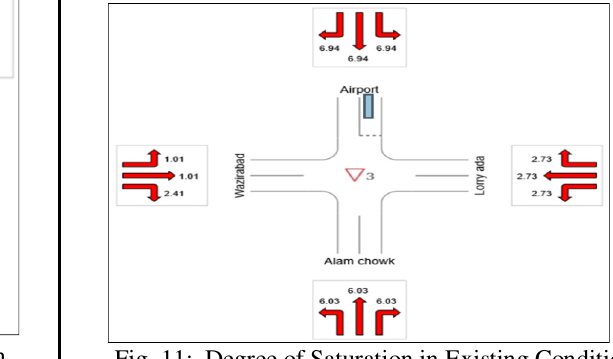
Fig. 10. Degree of Saturation in Modified Condition Fig. 11: Degree of Saturation in Existing